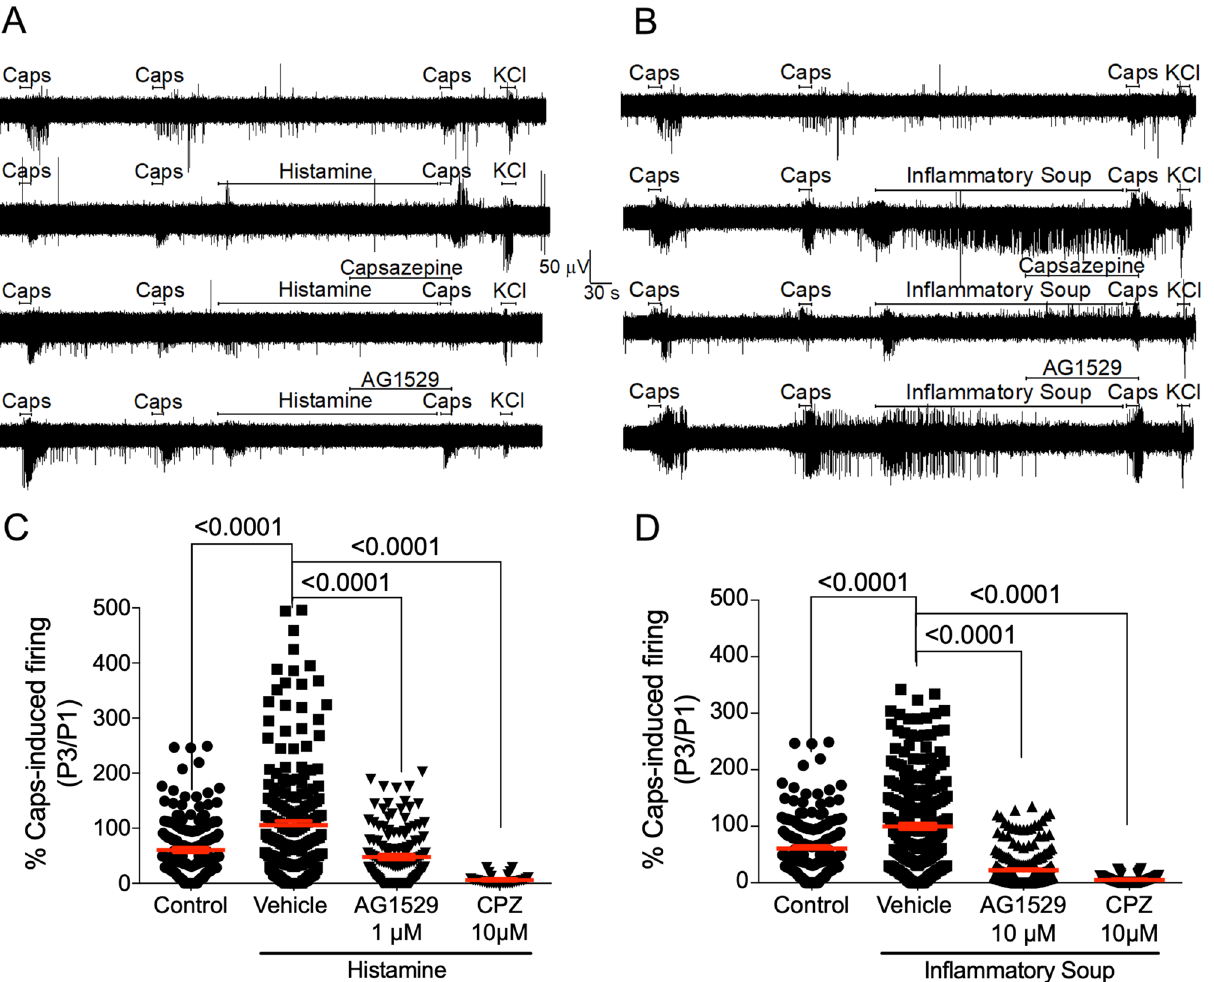
Figure 8. AG1529 reduces algesically-sensitized capsaicin-induced nociceptor excitability. ( A ) Representative MEA recordings of capsaicin-evoked APs and its sensitization by instillation of 50 µM histamine 2 min before the third capsaicin pulse, along with the effect of 10 µM capsazepine or 1 µM AG1529 added 2 min before the third capsaicin pulse (P3). ( B ) Similar protocol that in ( A ) but sensitization was triggered by an inflammatory soup containing 50 µM histamine, 1 µM bradykinin and 10 µM ATP. ( C , D ) Normalized capsaicin-induced firing of the third pulse (P3) with respect to the first one (P1) for the different treatments. Data are expressed as mean ± SEM, and analysed using the One-Way Anova (F(3,553) = 28.28, p < 0.0001 for panel ( C ); and F(3,794) = 144.5, p < 0.0001 for panel D ) followed by the Bonferroni´s post-hoc test, p-values for statistical difference are indicated. N (independent experiments) = 3, nº of electrodes = 50–200). Data of vehicle without histamine or inflammatory soup were obtained in independent experiment, N = 3 and number of electrodes